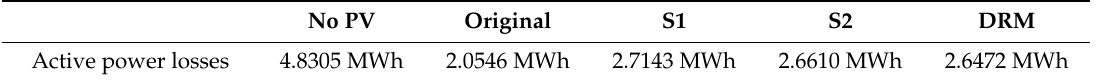
Table 6. Active power losses from three strategies.